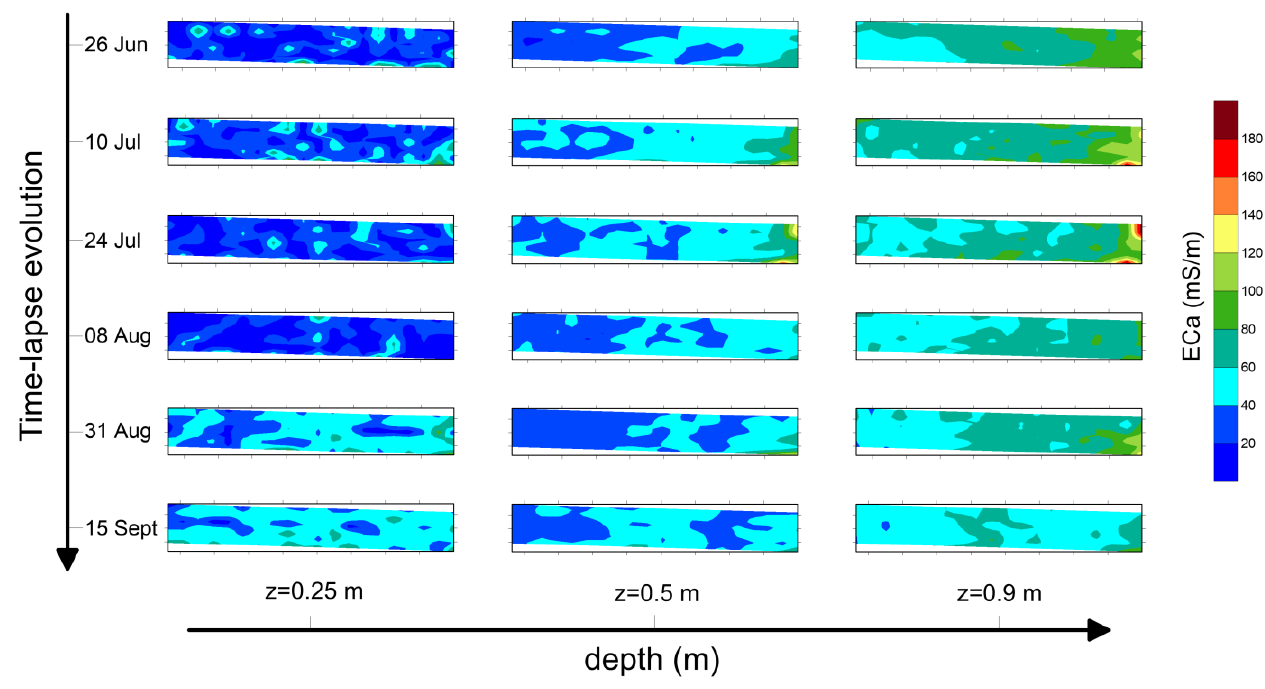
Figure 5. Maps of ECa recorded on the plot A2 for 3 depths (z = 0.25 m, z = 0.5 m and z = 0.9 m) and 6 temporal steps.